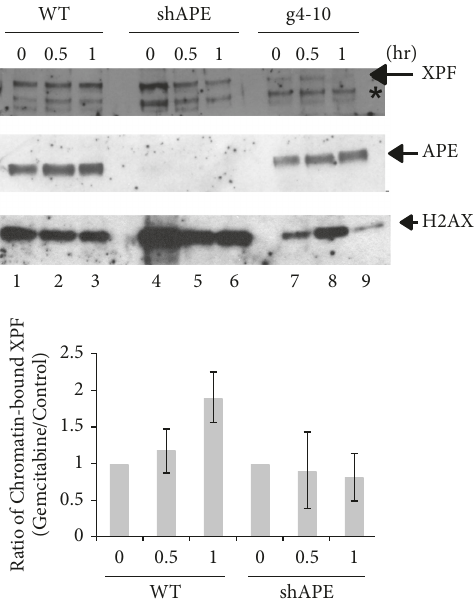
Figure 3: Gemcitabine-induced recruitment of XPF to chromatin depends on APE . HCT116, APE-suppressed HCT116 (HCT116 shAPE), and XPF-deficient HCT116 (HCT116 g4-10) cells were treated with 1 𝜇 M of gemcitabine and chromatin fractions were isolated in the indicated time. The presence of XPF and APE was detected by western blots. The asterisk ( ∗ ) shows a cross-reacted protein with the anti-XPF antibody. Histone H2AX was used as a loading control. Gemcitabine-induced recruitment of XPF to chromatin (lanes 1-3) was compromised in HCT116 shAPE cell line (lanes 4-5). The chromatin-bound APE is not changed by the gemcitabine treatment (lanes 4-6, Supplementary Figure 5). A signal of XPF (and APE) was normalized with a signal of H2AX in each chromatin fraction using ImageJ software. Then a ratio of chromatin-bound XPF with gemcitabine to XPF in control was determined and depicted as bar graphs. Three independent exper- iments were performed and averages of the ratio at indicated time points were plotted. The error bars show standard deviations. Only the difference in the chromatin-bound XPF between chromatin from control experiments and chromatin that was incubated one hour with 1 𝜇 M gemcitabine is statistically significant in HCT116 (p <